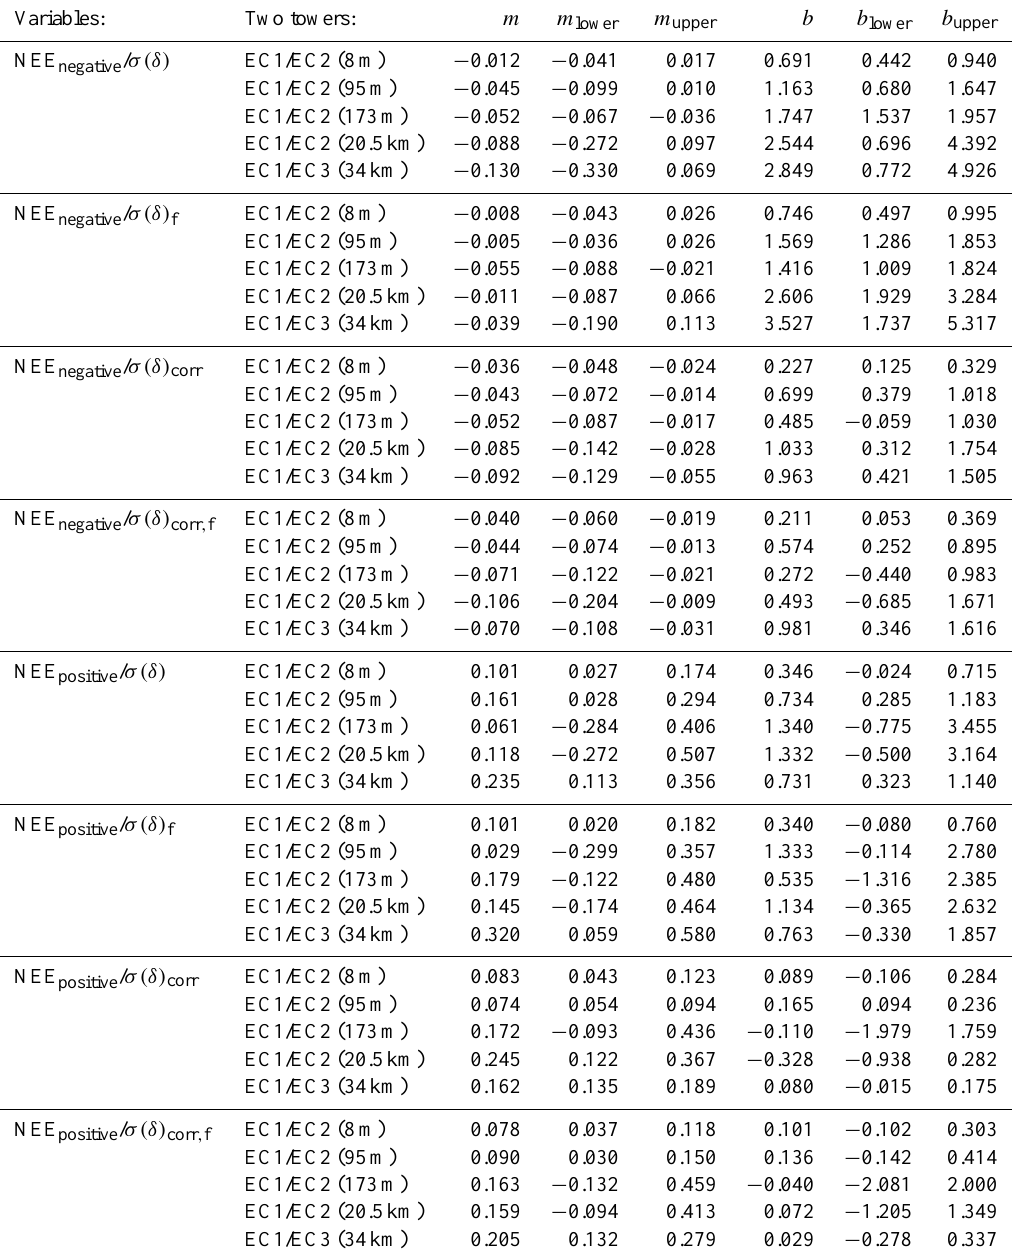
Table A1. Summary of the 95% confidence intervals for the lin- ear regression coefficients of the NEE magnitudes – standard error relationships determined with Eq. (1) for the four two-tower based correction schemes and the five EC tower